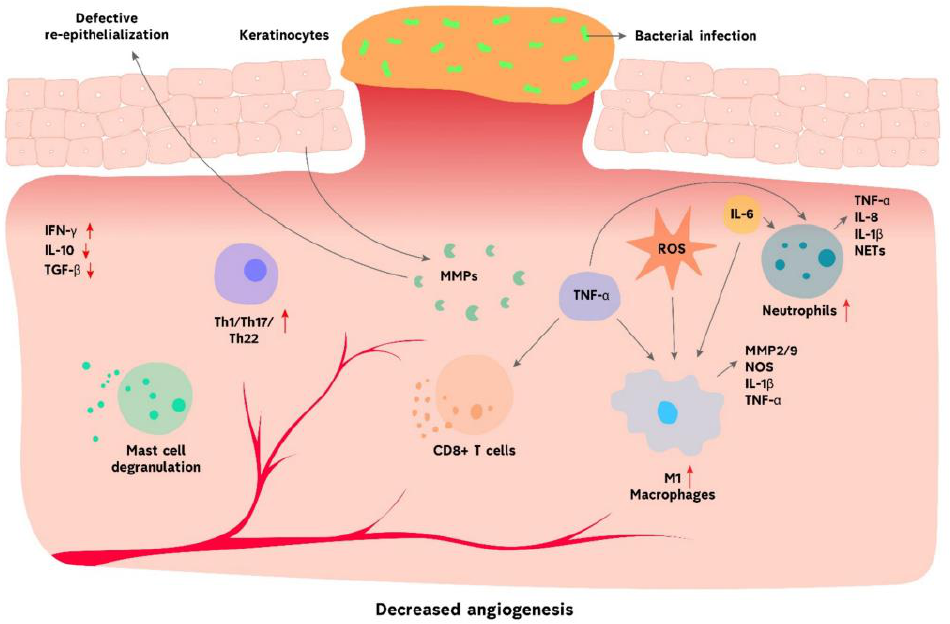
Figure 2. The immune environment of chronic wounds